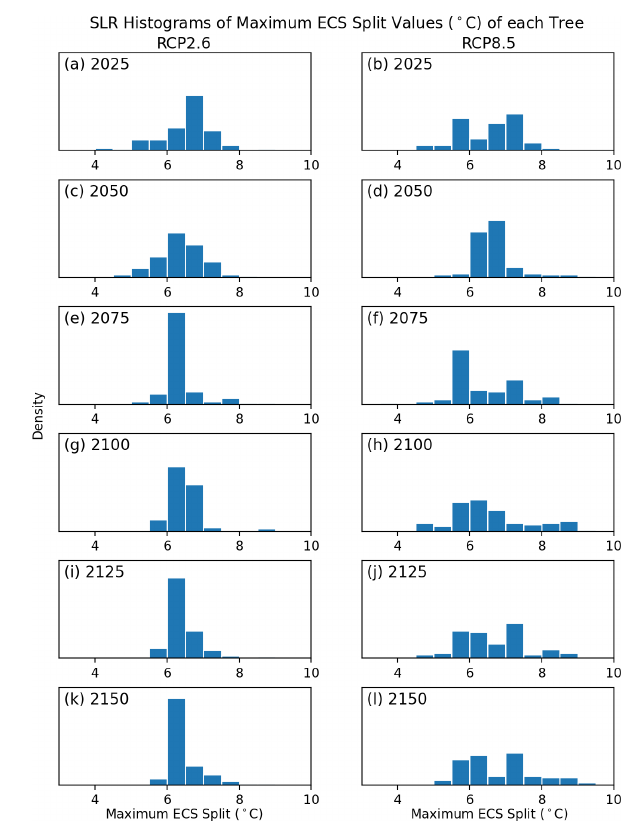
Figure A4. Distributions of the maximum equilibrium climate sen- sitivity (ECS) split value from each decision tree in the fitted ran- dom forests. The left column of plots depicts the maximum ECS split distributions in the RCP2.6 forests, and the right column de- picts the maximum ECS split distributions in the RCP8.5 forests.